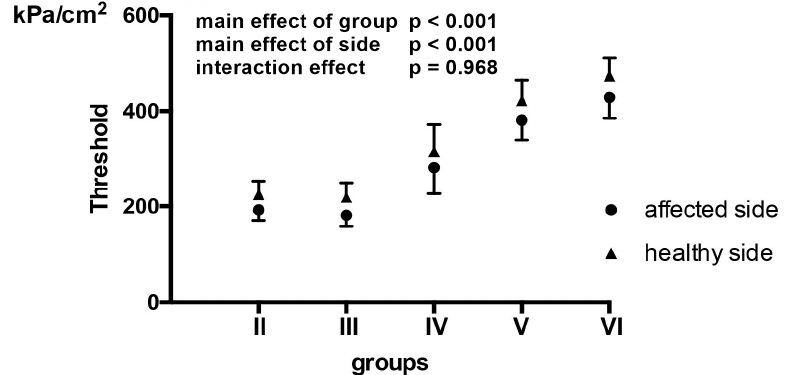
Figure 2. Pain threshold values among patients with Bell’s palsy regarding the affected side. Pain threshold levels of the affected side (black dots) and the healthy side (black triangles) are presented as averages ± standard deviation (whiskers). Pain threshold was assessed by two-way ANOVA (factors: group—II, III, IV, V, VI; side—affected/healthy side). There was no interaction effect ( p = 0.968), but a significant effect of group ( p < 0.001) and side ( p < 0.001).